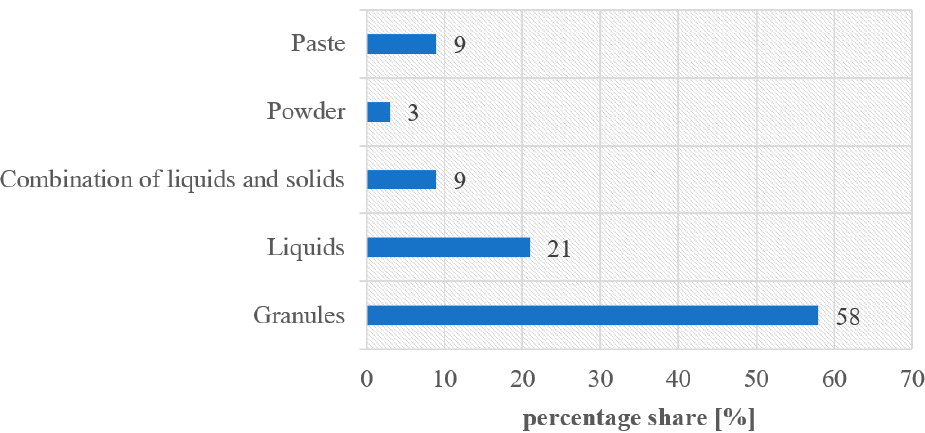
Figure 6. Preferred form of fertilizers.